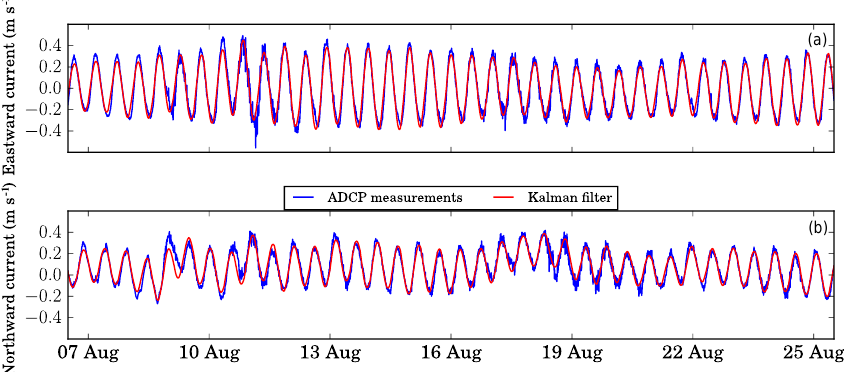
Figure 6. Seventeen-day time series of measured currents and Kalman filter estimated currents for the eastward component (top panel) and the northward panel (bottom panel).